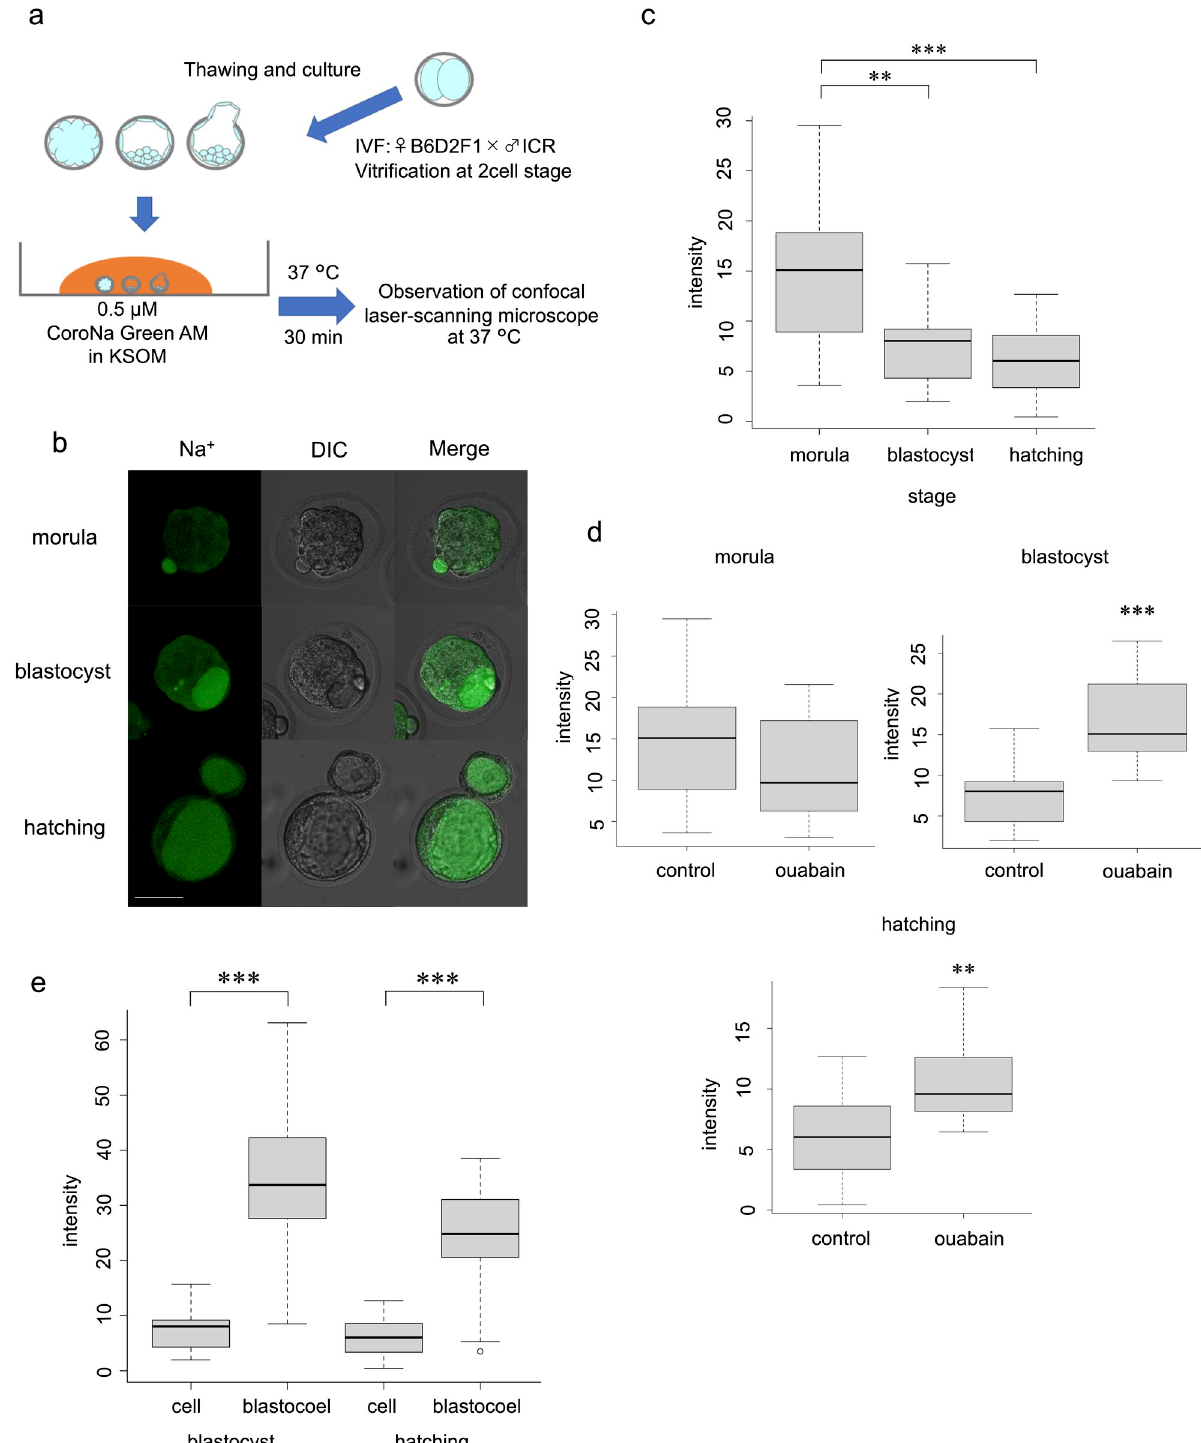
Fig 1. Live visualisation of Na + and intensity analysis using CoroNa Green AM. (a) Protocol for CoroNa Green AM. (b) Images of embryos at morula, blastocyst, and hatching stages. Scale bar, 50 μ m. (c) Comparison of CoroNa Green AM fluorescence intensity at each stage without ouabain. Wilcoxon rank sum test: �� p < 0.01, ��� p < 0.001. (d) Effect of ouabain at each stage. Wilcoxon rank sum test: �� p < 0.01, ��� p < 0.001. (e) Comparison of intracellular and blastocoel fluorescence intensity. Wilcoxon rank sum test: ��� p < 0.001.